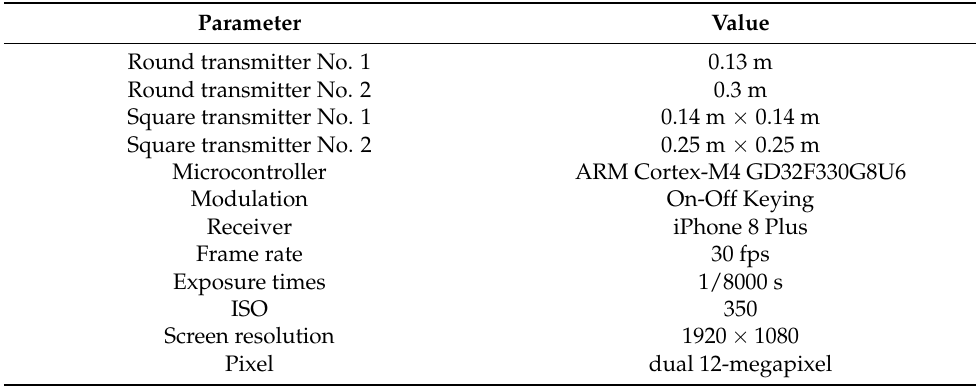
Table 1. Experiment